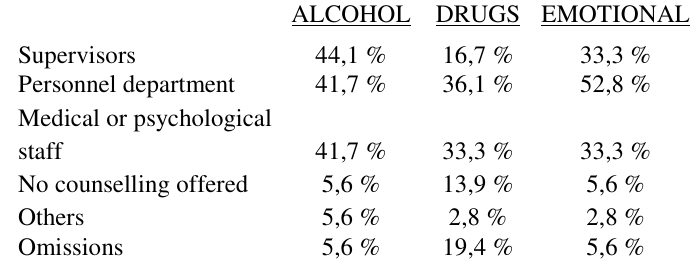
SOURCES FOR IN-COMPANY